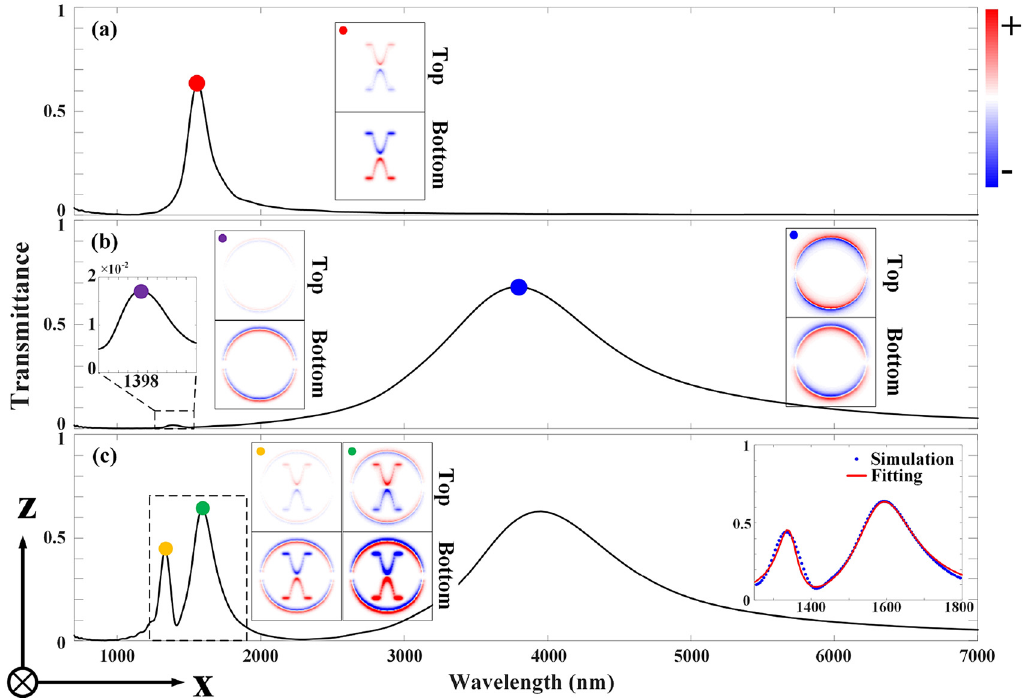
Figure 2: The origin of the near-infrared plasmonic FR in a hybrid metasurface. Transmittedspectracorrespondtoperiodicarrayswithindividual(a)PHand(b)CRAunitcells,aswellas(c)thehybridmetasurface.Theinsets of (a) and (b) show the charge distribution of the individual PH and CRA structures at the marked wavelength, respectively. The left inset of (c) shows the charge distribution of the hybrid metasurface. While the right inset of (c) shows the related transmitted spectra (black dashed box) of the hybrid metasurface, with the blue dots and red solid curve being the simulation and fi tting, respectively. The geometrical parametersaresetasfollows: P x = P z =600nm, R 1 =242.5nm, D =10nm, L =300nm, W =200nm, a p =0.25,and b p =20.FR,Fanoresonance; PH, parabolic-hole; CRA,